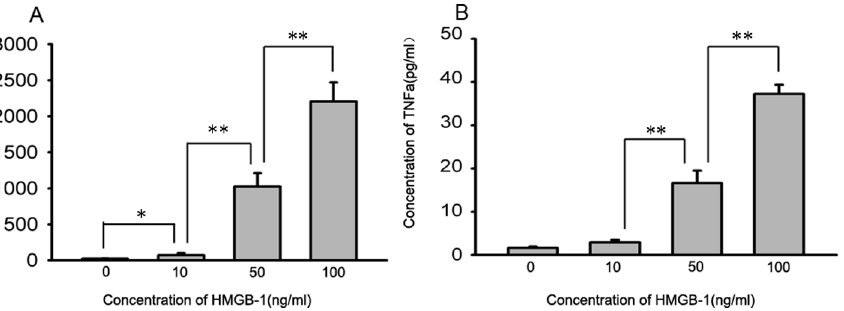
Figure 2. IL-1 b and TNF- a levels in culture media change after HMGB-1 stimulation in NR8383. NR8383 cells were stimulated with rhHMGB-1at different concentrations and then the IL-1 b and TNF- a levels in the culture media were evaluated by ELISA assay at 24 h post-treatment. After treatment, the IL-1 b levels increased slightly in the 10 ng/ml HMGB-1 group. In the 50 and 100 ng/ml HMGB-1 groups, the levels of IL-1 b increased dramatically (A). Compared with the control group, TNF- a levels did not change in the 10 ng/ml HMGB-1 group, but clearly increased in the 50 and 100 ng/ml HMGB-1 groups (B). Data are shown as the mean 6 SD, n=6, * P , 0.05, ** P , 0.01.